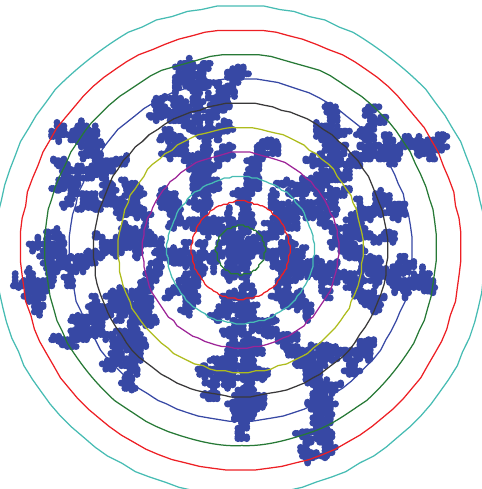
Figure 1: A DLA model showing the particle-ripple duality of city space. (cid:3) Note that the cluster with a dimension D ≈ 1 . 7665 is created in Matlab by using the DLA model. The center of the circles is the origin of growth as the location of the “seed” of DLA.